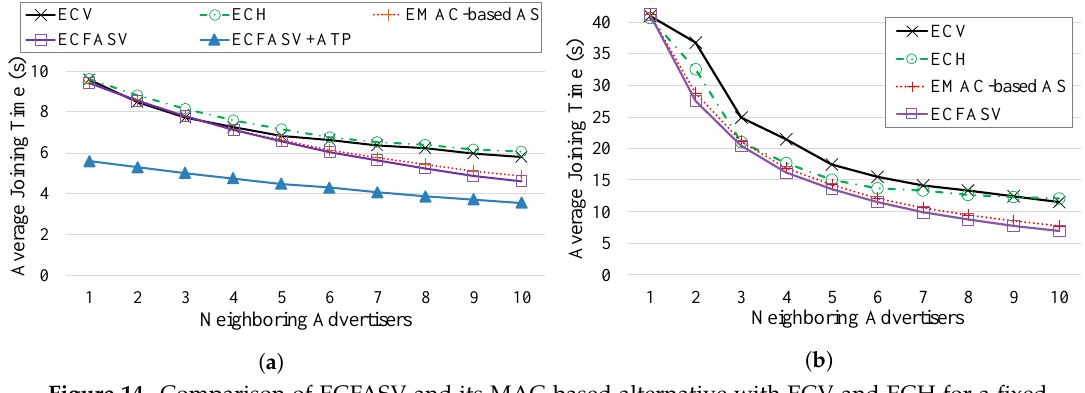
Figure 14. Comparison of ECFASV and its MAC-based alternative with ECV and ECH for a fixed joining node, when ( a ) the joining node is a neighbor of the PAN coordinator and ( b ) when